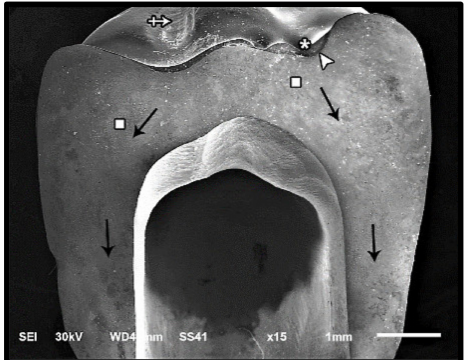
Figure 5. SEM micrograph represents class III failure mode of lithium disilicate fractured specimen showing the fracture origin (asterisk) at the loading occlusal surface of the restoration, hackle lines (square) indicating the direction of crack propagation (black arrow), arrested line (arrow head), and loss of glazing layer at the position of loading piston (cross-arrow).